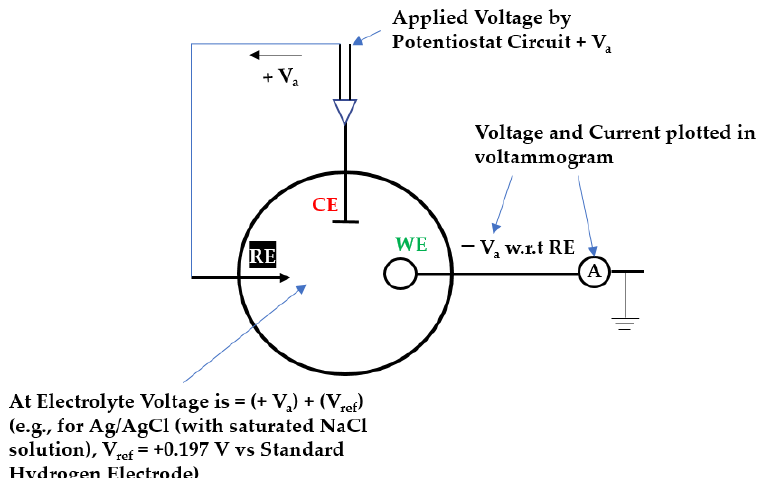
Figure 6. A simplified diagram to show the function of three electrode in the RDE/RRDE system. working electrode (WE), reference electrode (RE), counter electrode (CE).